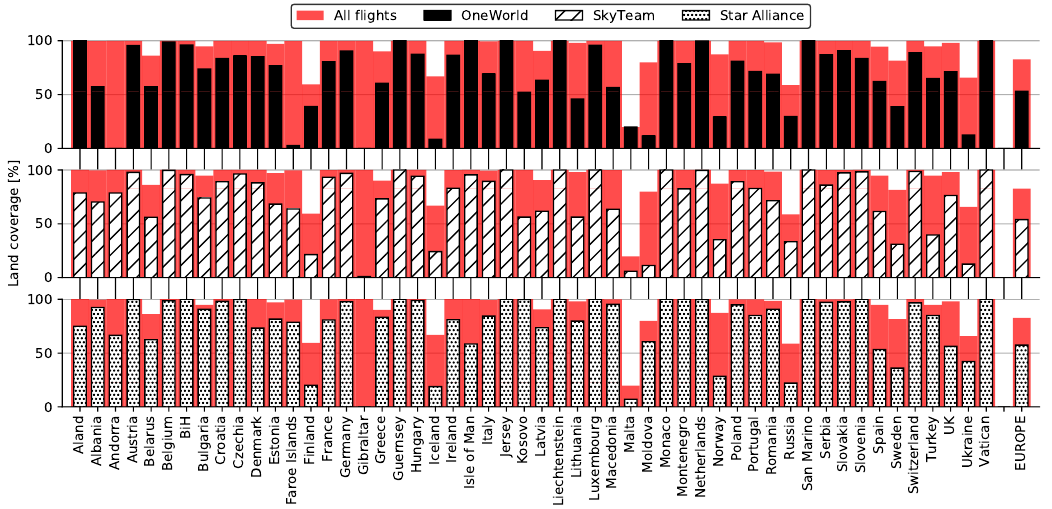
Figure 8. Land coverage by all flights (background red) and individual alliances (monochrome bars) with Imperx T9040.